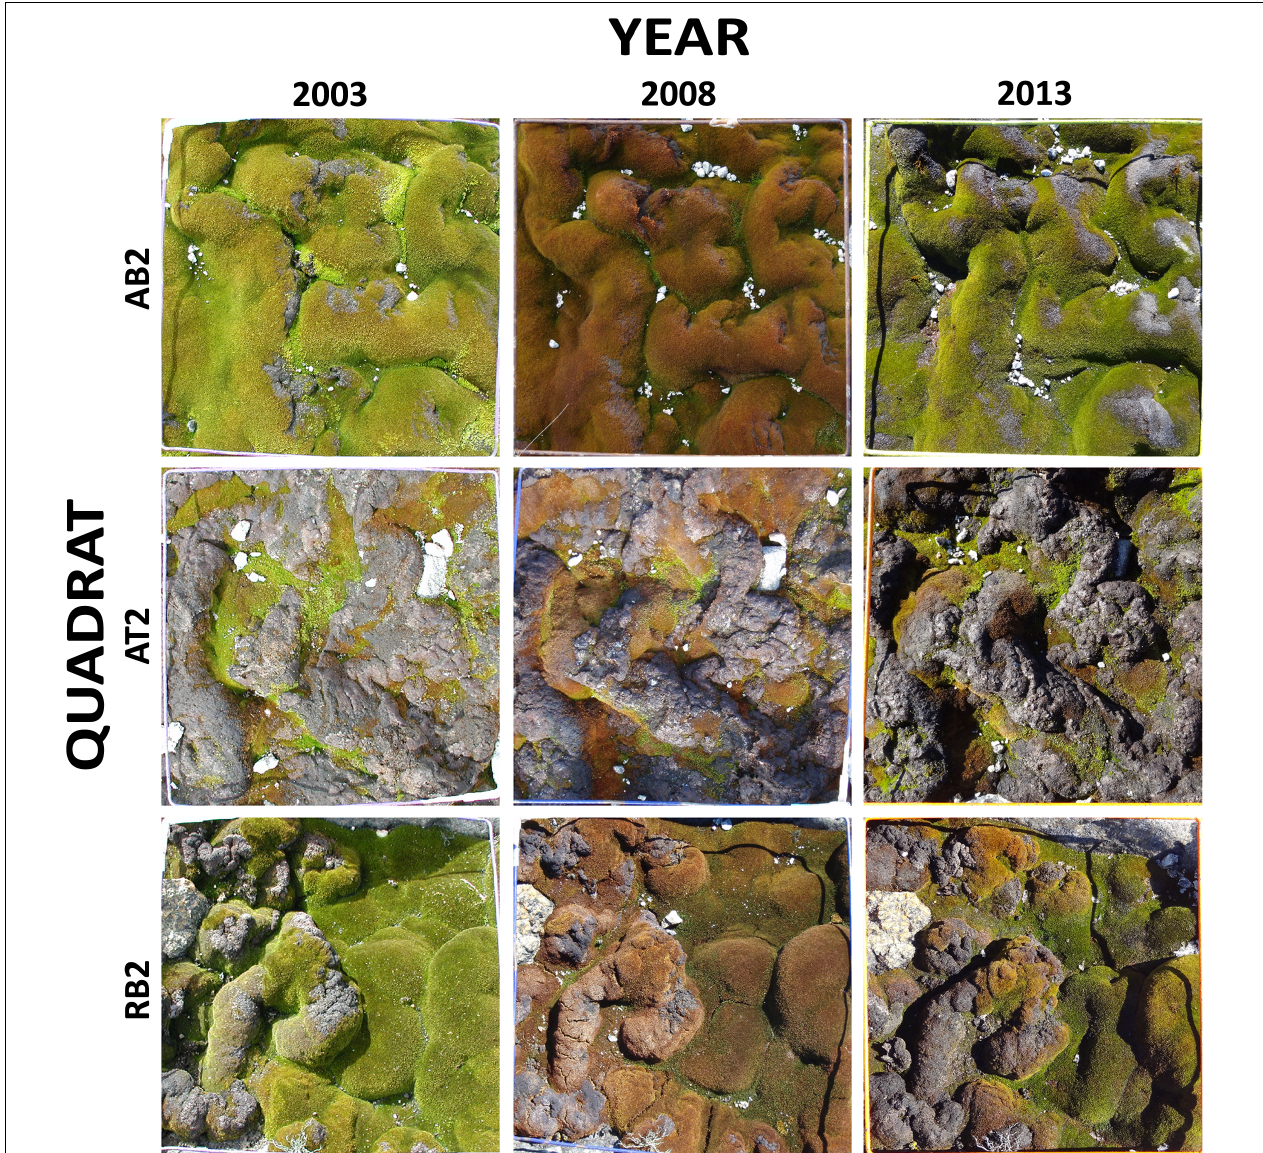
FIGURE 1 | Test mosaic of nine quadrat images from sites in the Windmill Islands, East Antarctica. The mosaic comprises photos of three quadrats, taken at 5 year intervals (2003, 2008, and 2013). AB2: ASPA 135 Bryophyte community quadrat 2, AT2: ASPA 135 Transitional community quadrat 2, RB2: Robinson Ridge Bryophyte community quadrat